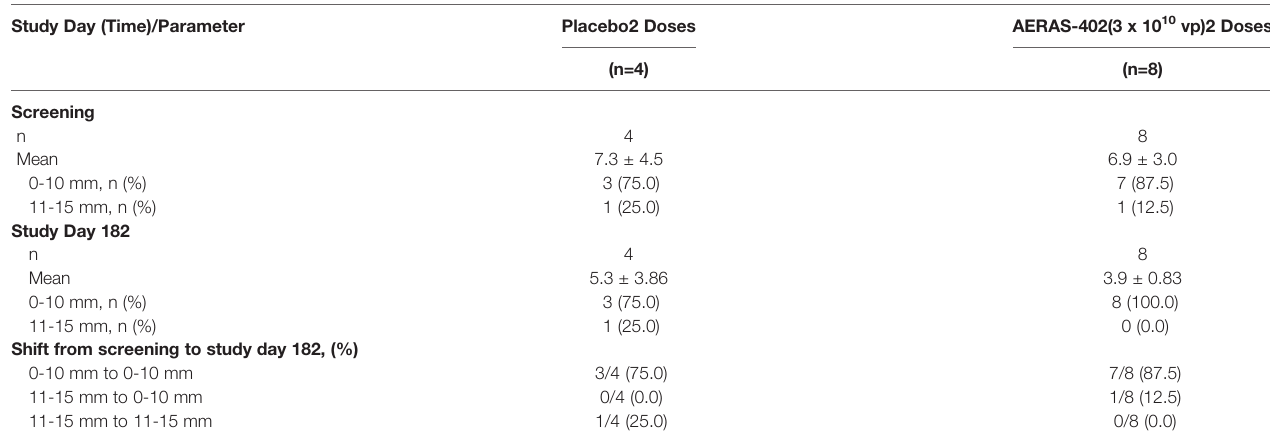
TABLE 4 | Tuberculin Skin Test (TST)